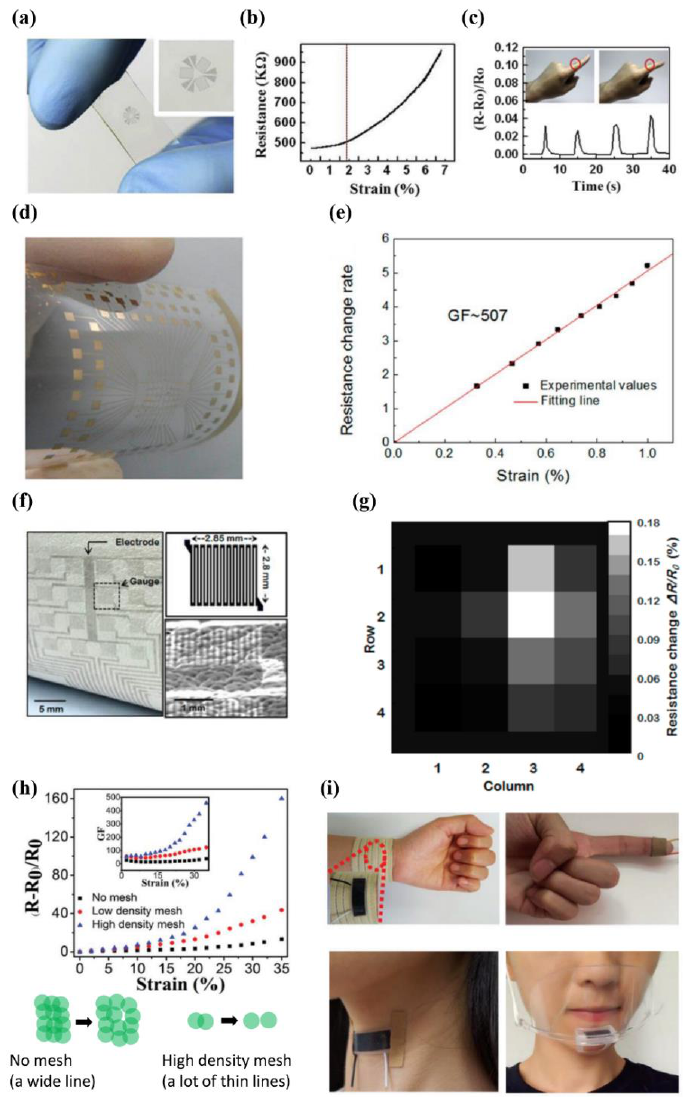
Figure 10. ( a ) Picture showing the transparent graphene strain gauge sensor; ( b ) change in resistance versus stretched strain; ( c ) the relative change in resistance during a stretching experiment of the device on the finger (reprinted with permission for Figure 10a–c from Ref. [14] Copyright 2012 Elsevier); ( d ) photograph of the strain sensor array based on the nanographene film; ( e ) the change in resistance rate with respect to applied strain (reprinted with permission for Figure 10d,e from Ref. [16] Copyright 2015 American Chemical Society); ( f ) photographic and SEM image of graphene strain gauge sensor array on animal leather, the structural information of the unit cell; ( g ) pressure distribution under gentle touch of 9 kPa (reprinted with permission for Figure 10f,g from Ref. [17] Copyright 2014 American Chemical Society); ( h ) output curve variation and the gauge factor values, according to the strain applied to the sensor (top: no mesh, a low-density mesh, and a high-density mesh). The illustration of the working principle (bottom); ( i ) the laser patterned graphene sensor attached onto the wristband, finger, face mask, and throat (reprinted with permission for Figure 10h,i from Ref. [15] Copyright 2017 Royal Society of